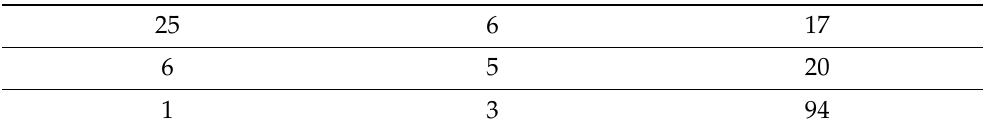
Table 12. Confusion matrix for Glove embedding with the Chi-Squared feature selection method; 150 features.